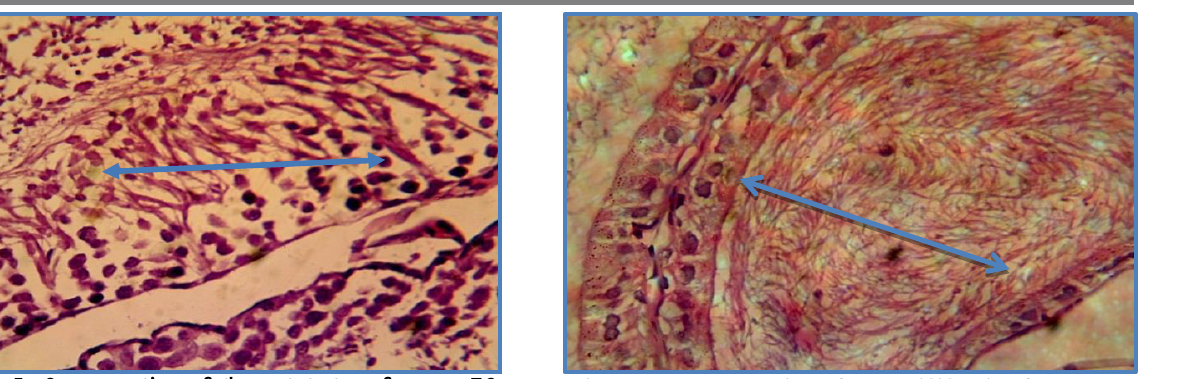
Figure, 9: Cross section of rat epididymis of group T2 showing the lumen was overfilled with sperms (H and E stain 40x).